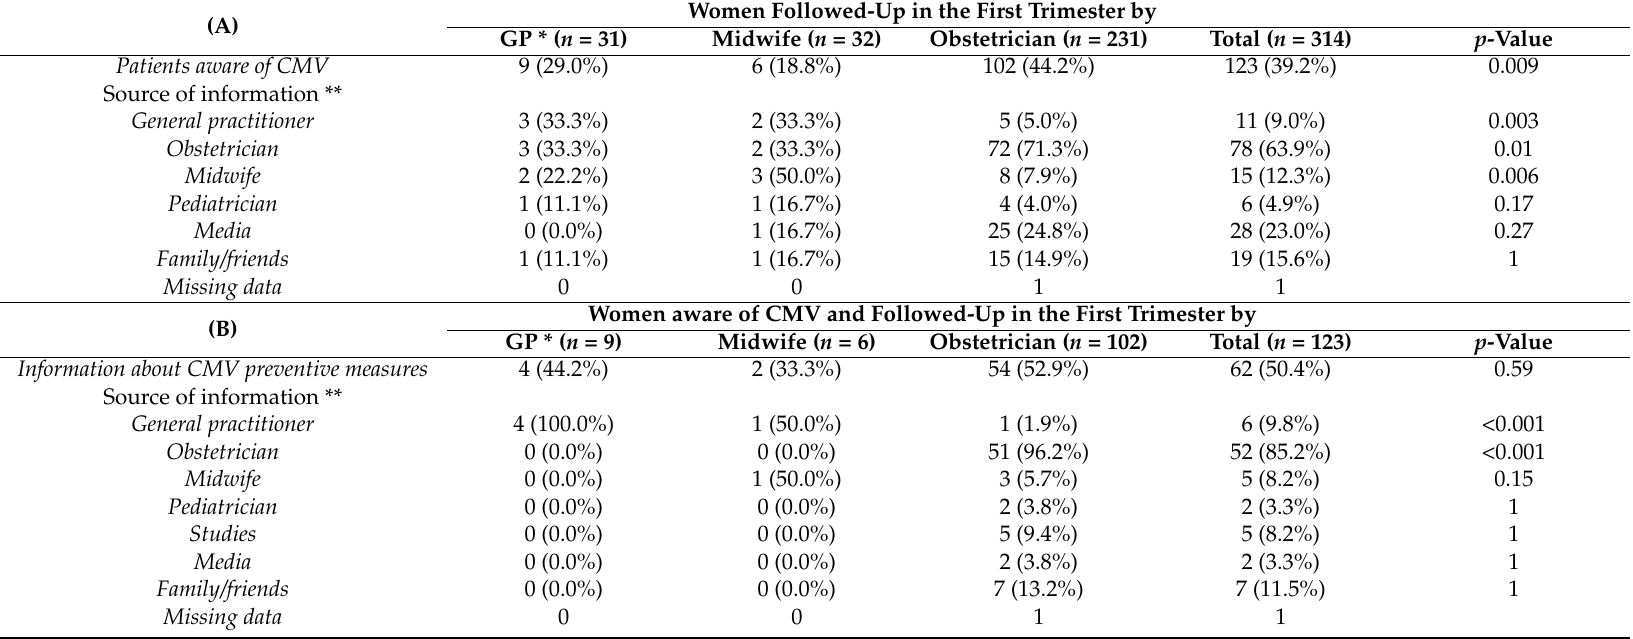
Table 2. Sources of information about CMV and preventive measures based on type of first trimester